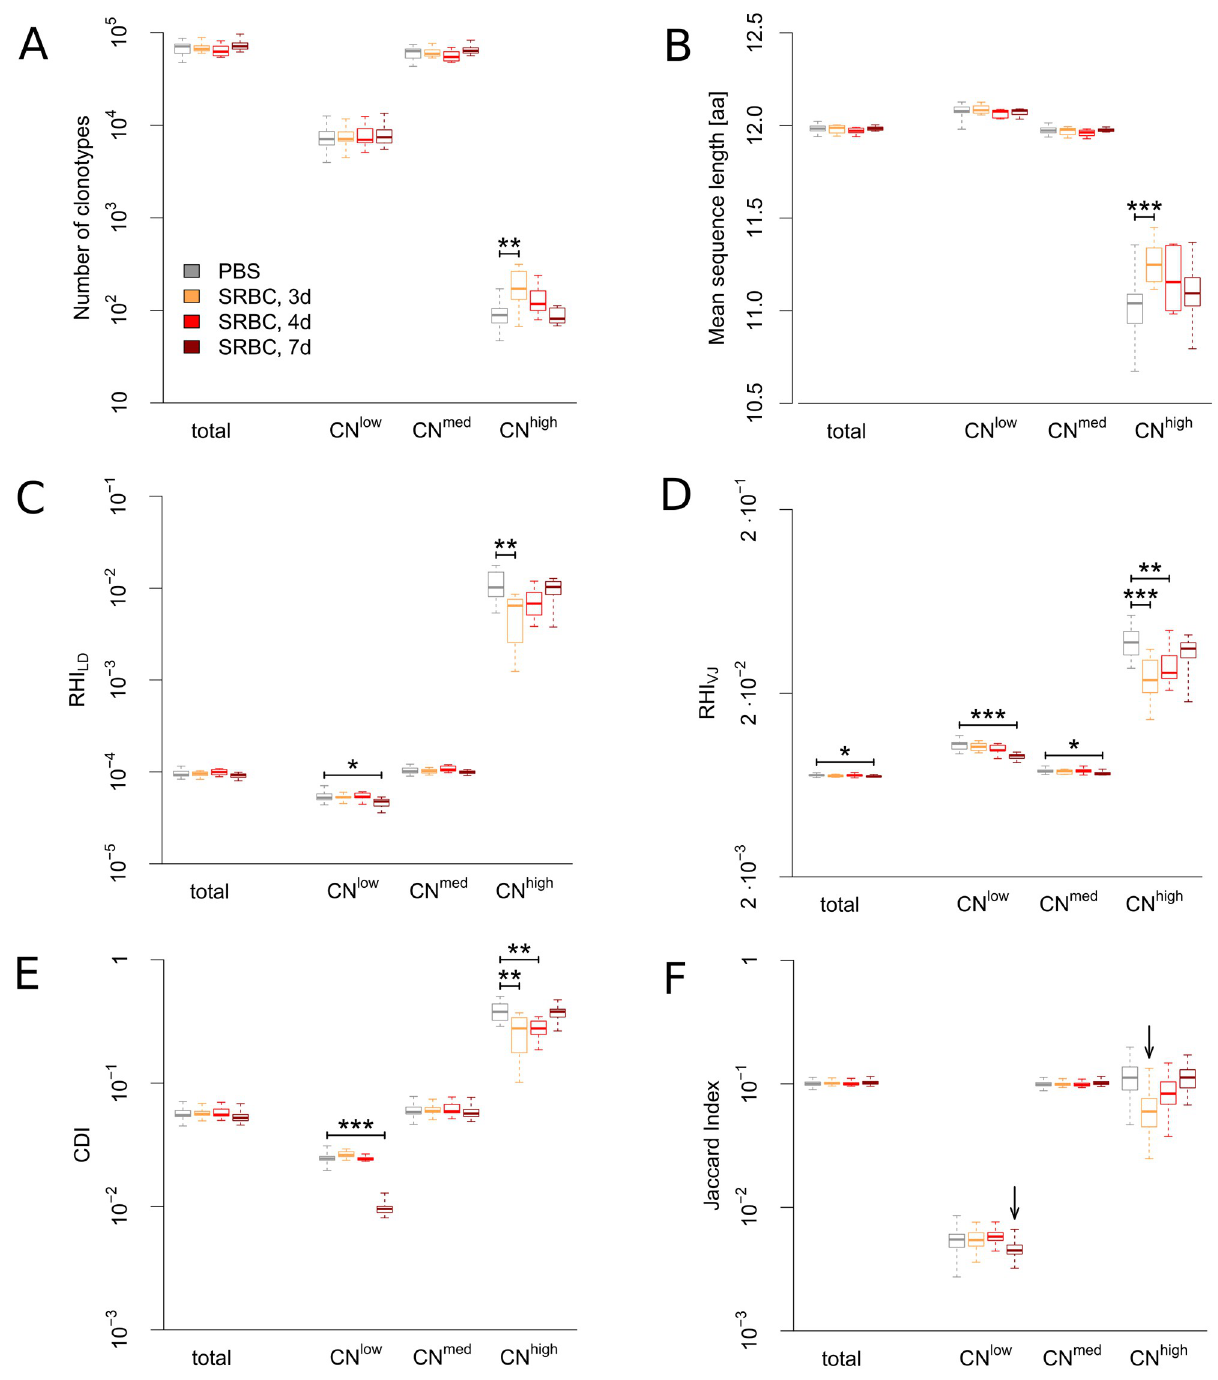
Fig 1. Immunization with SRBC induces consistent parameter shifts in two distinct copy number fractions of the T cell receptor repertoire. The data are presented either as total T cell receptor repertoire (containing all clonotypes) or divided into three clonotype fractions according to their copy number: clonotypes of low (CN = 2), intermediate (2 < CN � 500) and high (CN > 500) copy number. The total T cell receptor repertoire and each copy number fraction were compared 3, 4 and 7 days (d) after injection of SRBC (n = 10 per time point) with control (PBS-injected) animals (n = 20). (A) Number of clonotypes, (B) Mean sequence length of the CDR3 β region, (C) Repertoire Homogeneity Index (RHI) capturing the homogeneity of CDR3 β sequences within animals (two clonotypes defined as similar if the Levenshtein distance of the CDR3 β regions is at maximum one), (D) RHI capturing homogeneity of gene usage (two clonotypes defined as similar if equal V- and J-segments were assigned), (E) Coding Diversity Index (CDI) capturing the diversity of nucleotide coding of the CDR3 β amino acid sequence of each clonotype, and (F) Jaccard Index measuring the clonal overlap of CDR3 β sequences from different animals. Boxplots display median, interquartile range and minima/maxima. For (A)-(E) immunized repertoires